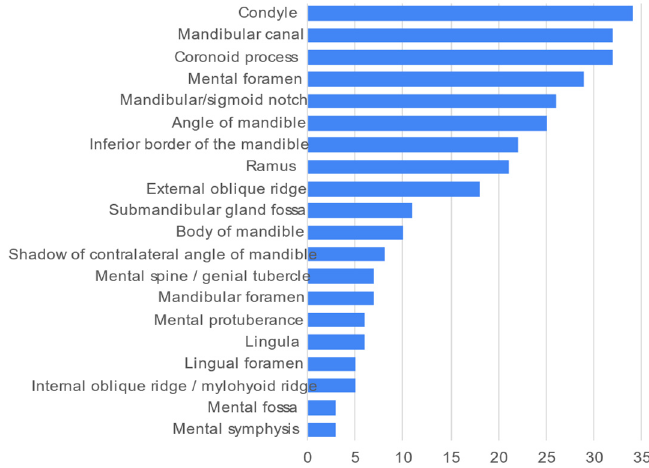
Figure 5. Frequency count of mandibular anatomical landmarks described in the 38 videos.